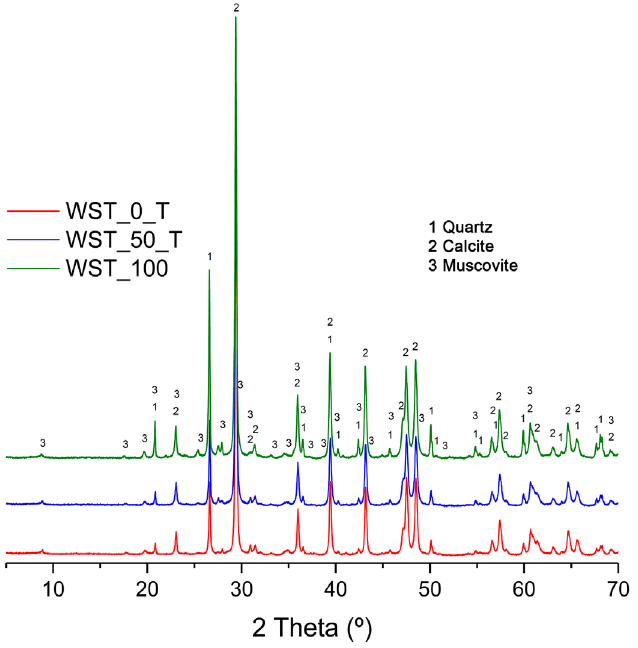
Figure 9. Comparative XRD analysis: WST_0_T (red line), WST_50_T (blue line), and WST_100 (green line).